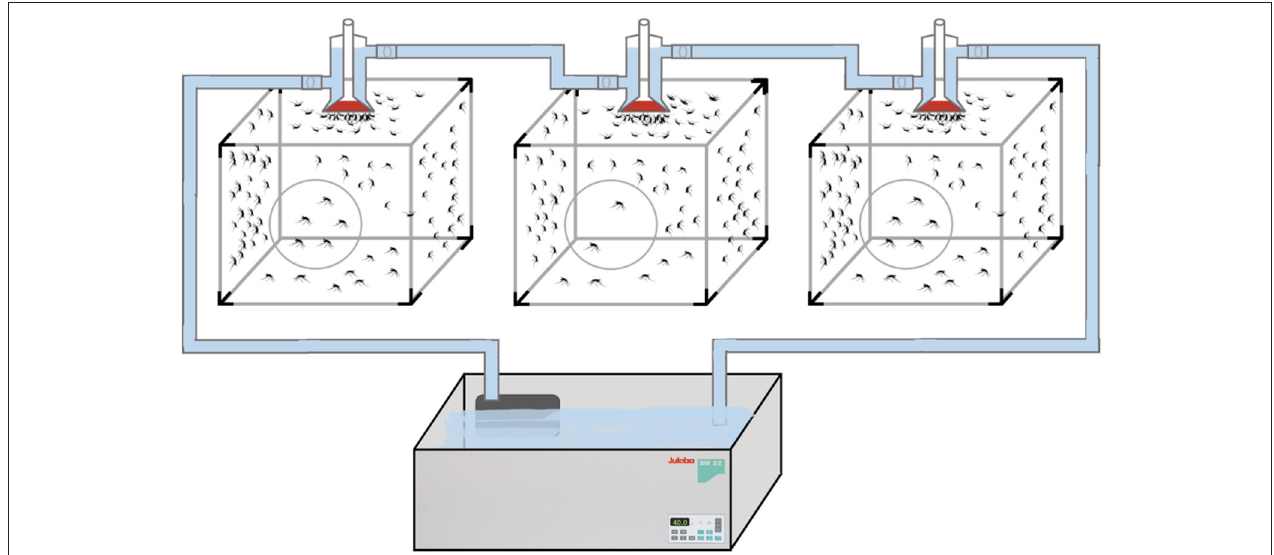
FIGURE 2 | Experimental feeding set-up with constant flow of circulating water.